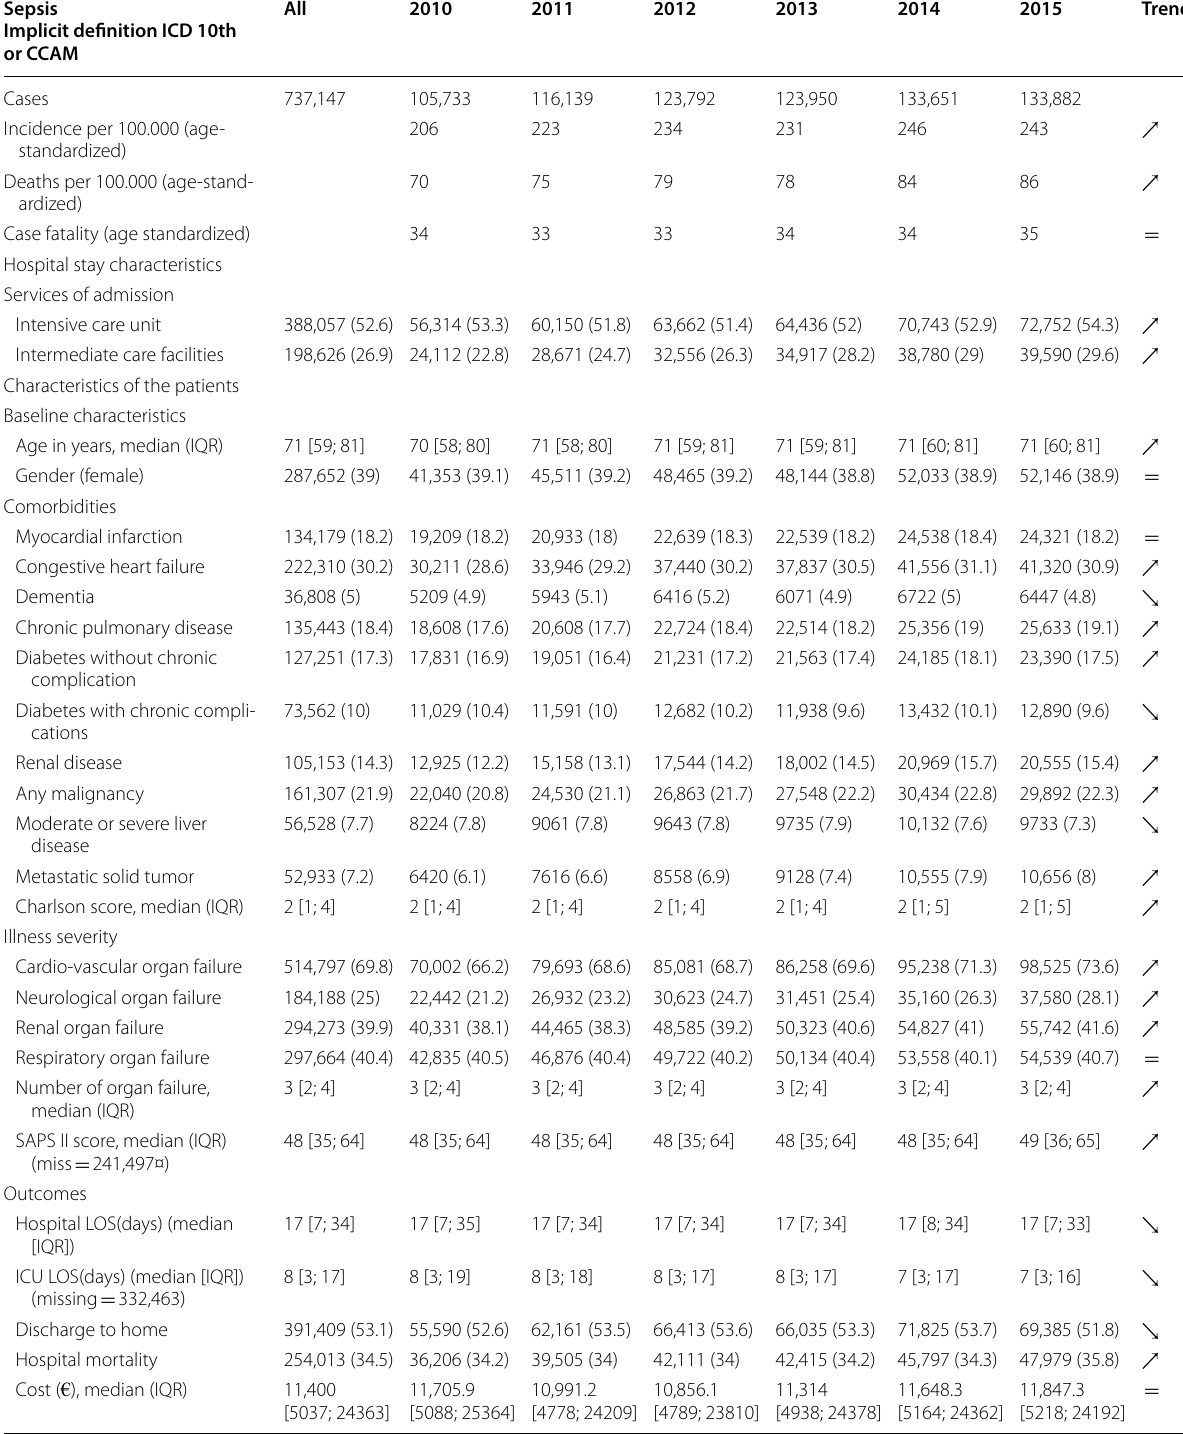
Table 1 Main characteristics of the included sepsis hospital stays in France between 2010 and 2015 and their associated temporal